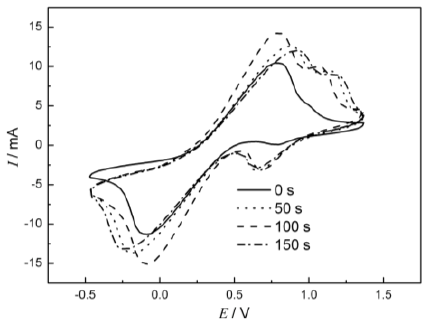
Figure 4. Cyclic voltammetry (CV) of copper-coated carbon cloths. These carbon cloths had deposition times of 0, 50, 100 and 150 s, respectively.